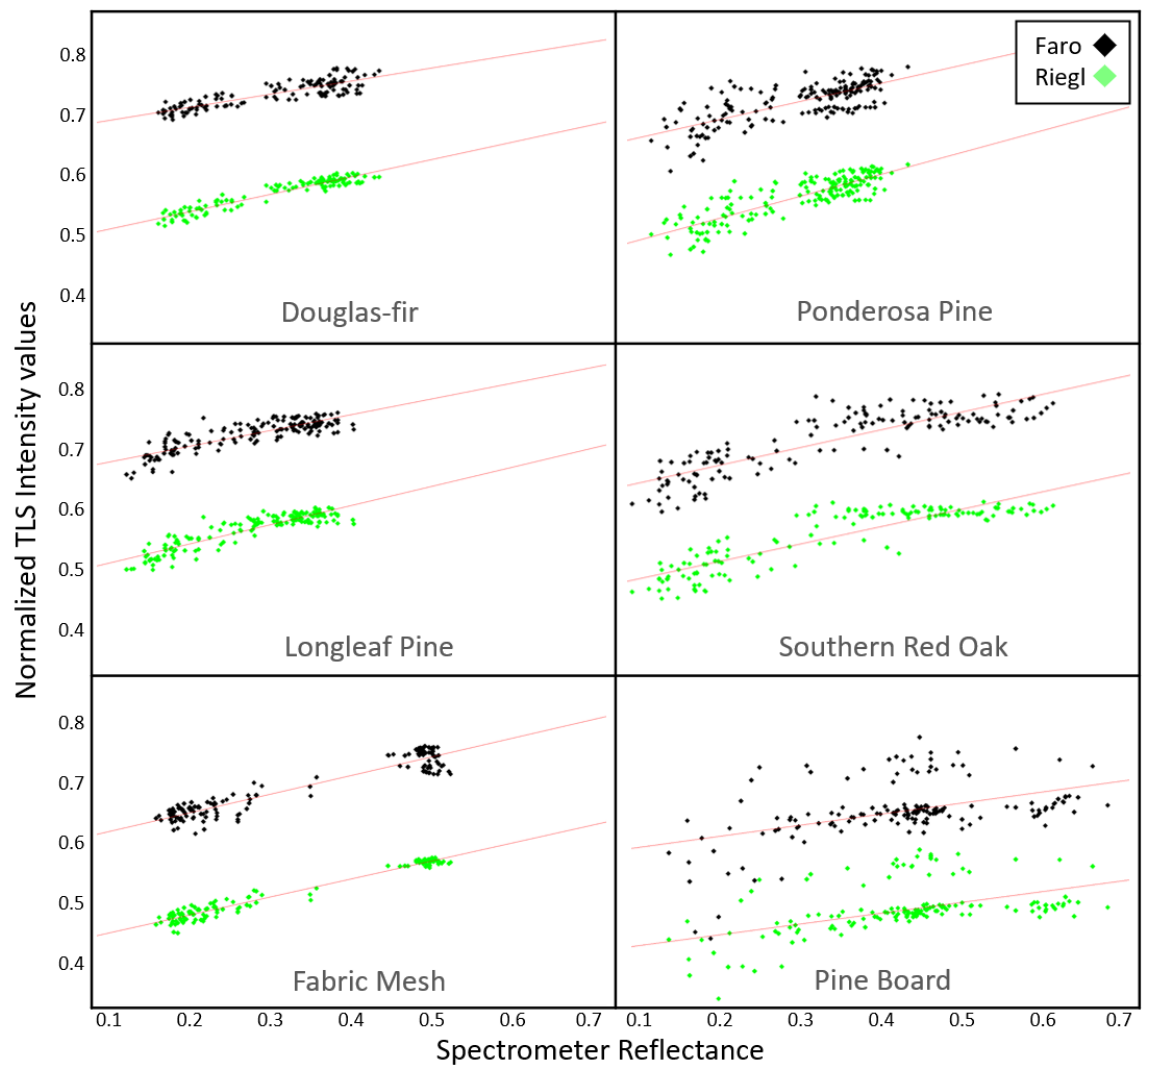
Figure 6. Linear relationship between reflectance values as measured by the spectrometer at 1550 nm and the mean intensity values of all lidar points from a sample. Intensity values were normalized on a scale between 0 and 1 for a direct comparison between the FARO and RIEGL units. The lower intensity values from the RIEGL unit are a product of this normalization and do not indicate that, overall, less energy was returned by each RIEGL pulse.